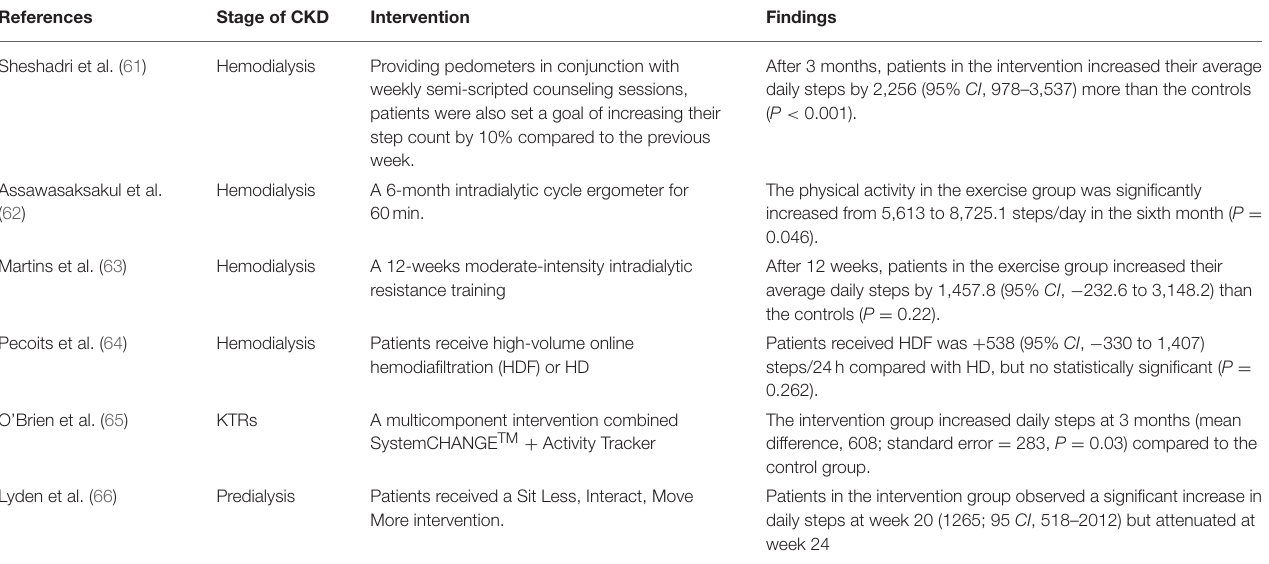
TABLE 3 | A summary of randomized control trials on increasing daily step counts in patients with